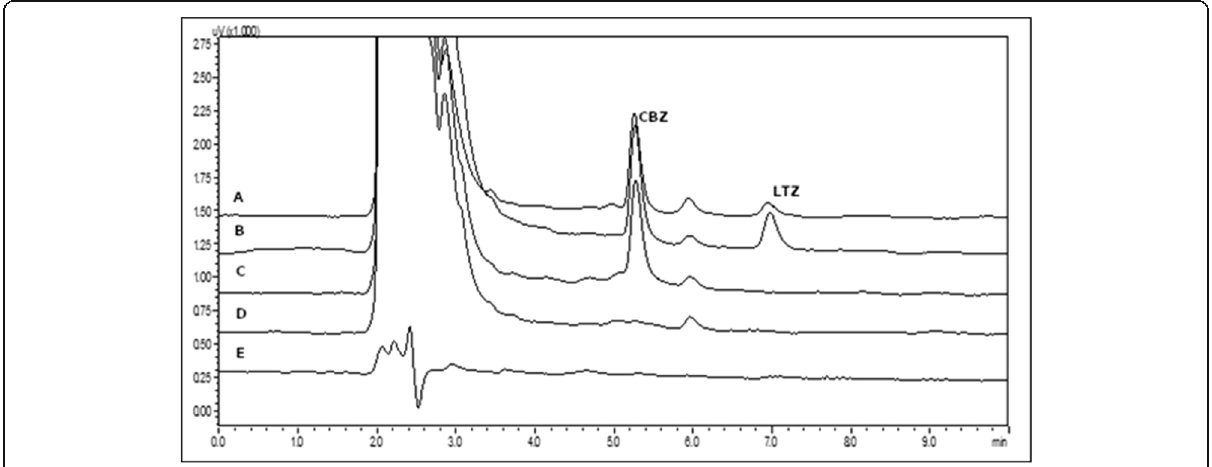
Fig. 3 Chromatograms of plasma samples and diluent eluted using the optimized chromatographic method. (A) Plasma sample from